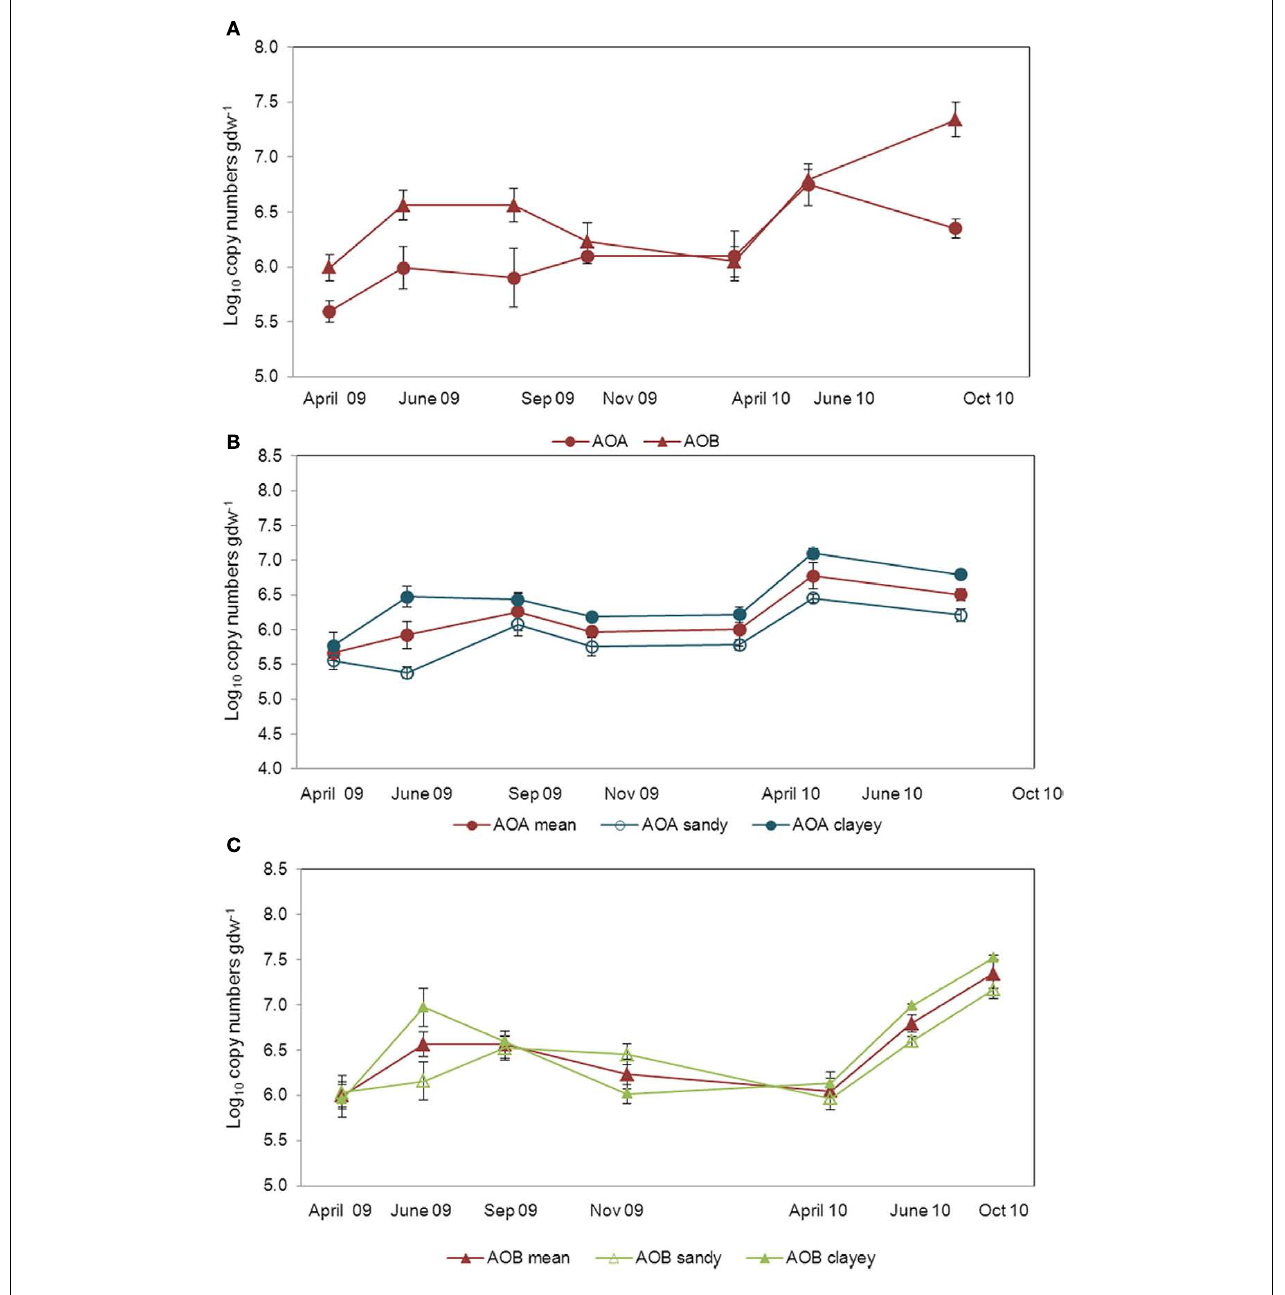
FIGURE 2 |Amplitude of variation in the community size ofAOA and AOB. Fluctuations in the community size were determined by real time quantification (qPCR) of amo A gene as a mean of all soils [ (A)